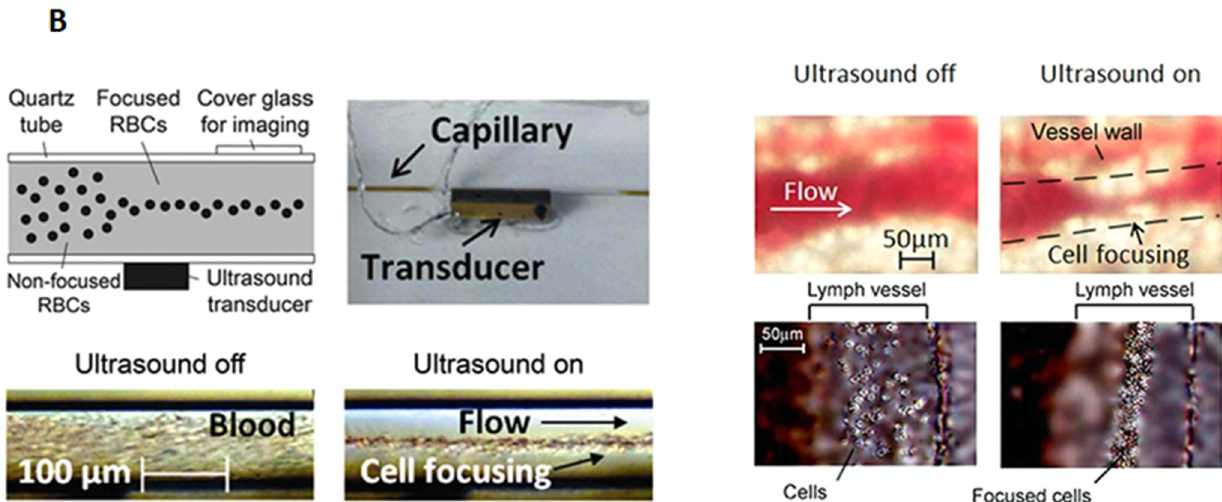
Figure 9. Acoustic focusing of microparticles in circular cross-section glass capillaries. ( A ) Ultrasonic microparticle concentration in a soft glass capillary ( d = 2.2 mm). Reprinted with permission from [61]. ( B ) In vitro and in vivo ultrasonic focusing of cells. In vitro ( left ): acoustic focusing of blood cells was performed in a circular quartz capillary ( d = 0.1 mm). In vivo ( right ): acoustic cell focusing in blood in a mouse ear vessel and acoustic focusing of cells (WBCs) in a 180 μ m diameter mouse mesenteric lymph vessel. Reprinted with permission from [65] .